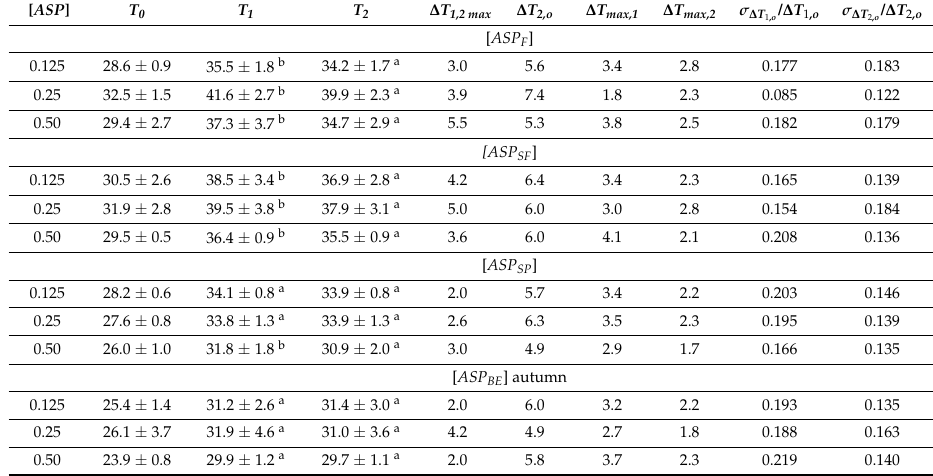
a,b Values of temperature accompanied by different letters are significantly different at 95.0% confidence